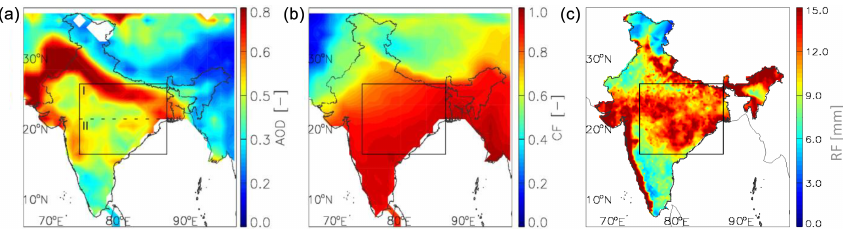
Figure 1. Climatological mean of (a) aerosol optical depth, (b) cloud fraction, and (c) daily rainfall for June through September 2002–2013. The black square box indicates the Indian summer monsoon region (ISMR) which is the focus of our analysis. Panel (a) illustrates the boundaries of regions I and II, used for sub-analysis (see the